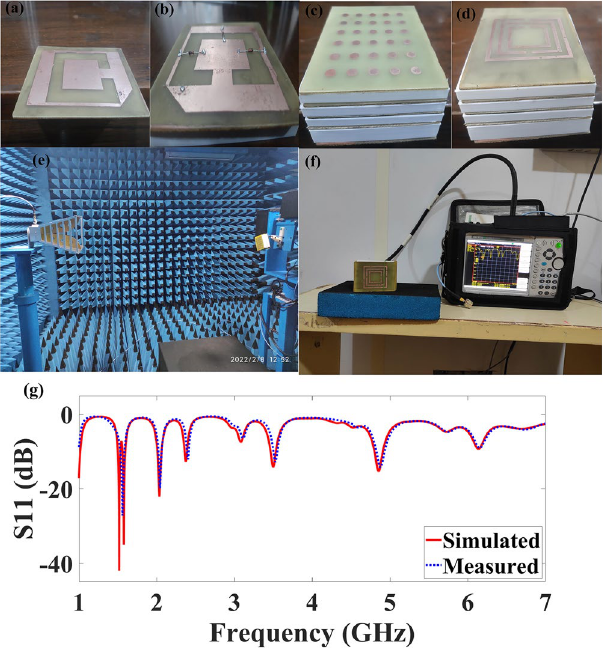
Figure 5. Fabricated structure and testing through the anechoic chamber (a) fabricated SRR based patch structure without pin diodes, (b) fabricated SRR based patch structure with pin diodes for switching mechanism to attain reconfiguration, (c) fabricated structure of 6 × 5 TW double layer superstrate structure placed upon SRR based patch structure separated using the 3D printed white hollow box of various thickness , (d) fabricated structure of four layer SRR superstrate structure placed upon SRR based patch structure separated using 3D printed white hollow box of various thickness, (e) antenna testing facility of anechoic chamber, (f) Reflectance response observation of four layer SRR superstrate structure placed upon SRR based patch structure (g) Comparison of simulated and measured results for SRR three layer structure combined with 6 × 5 TW single layer as a top layer, we attain five frequency